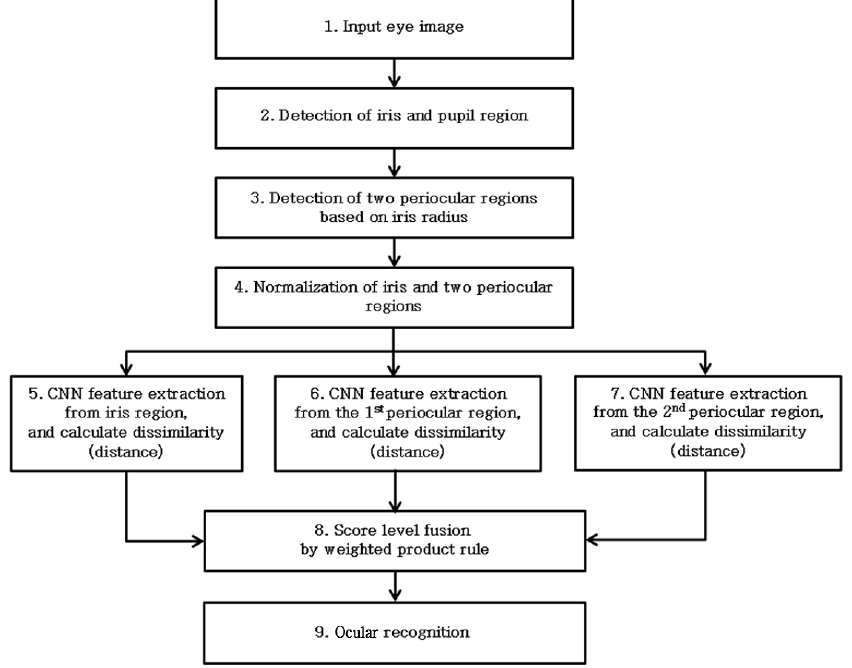
Figure 2. Overview of the proposed method.